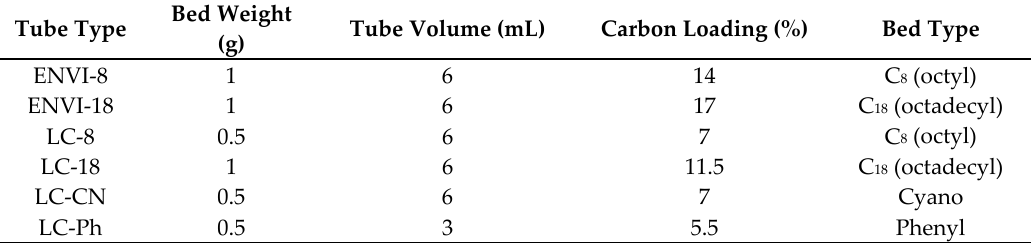
Table 2. Characteristics of Supelclean™ Tubes applied to Solid Phase